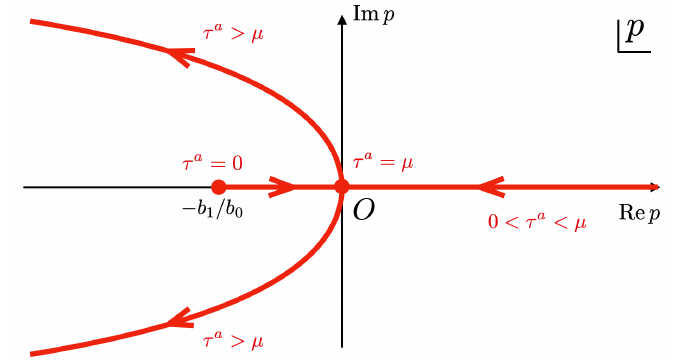
Figure 13 . Trajectories of p ∗ , 1 and p ∗ , 2 in the NLL approximation of ˜ X ( k = 1 ), as τ ∈ R is raised from 0 to ∞ . At τ = 0 , p ∗ , 1 = + ∞ and p ∗ , 2 = p 1 = − b 1 /b 0